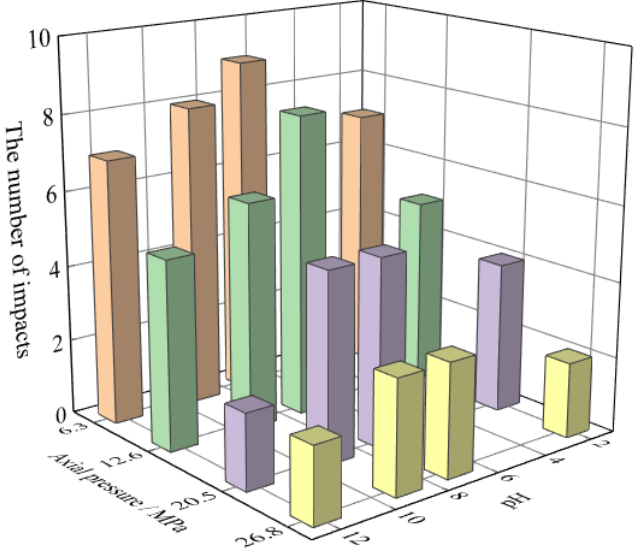
Figure 6. The trend of cyclic impact number.